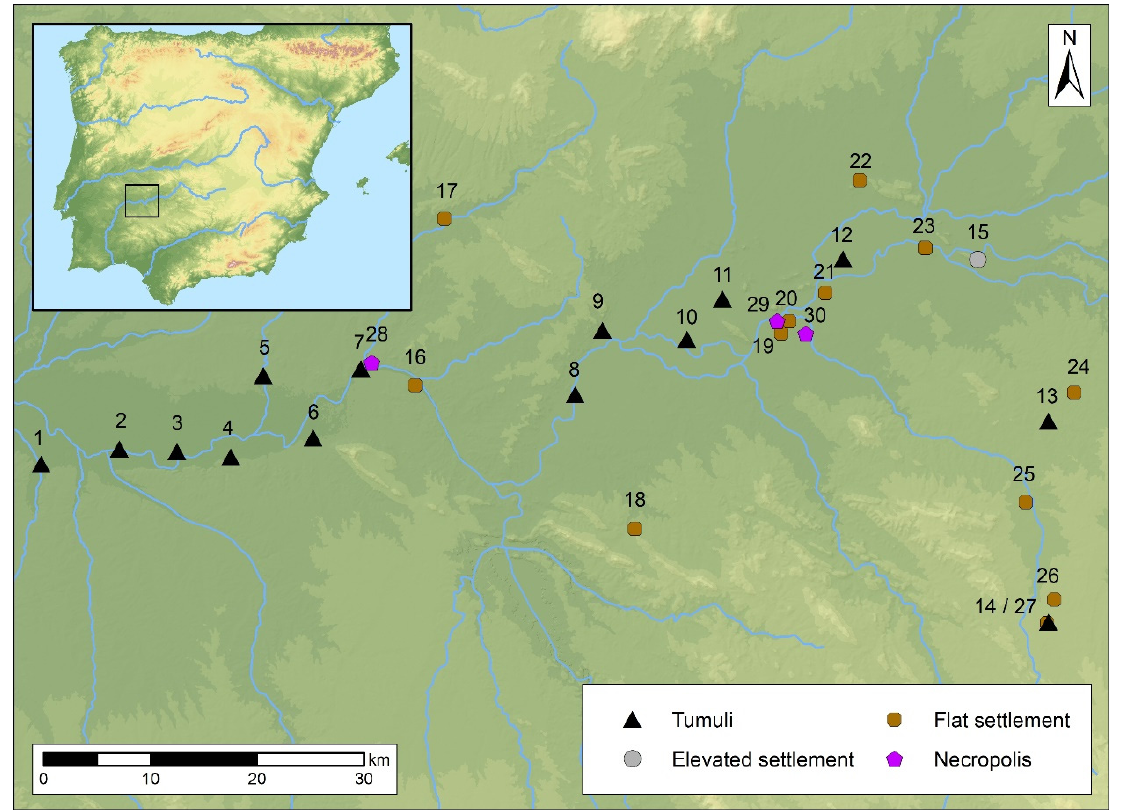
Figure 1. Map showing settlements in the middle Guadiana basin during the first Iron Age. 1. Huerta de Don Mateo; 2. Casas del Cerro de la Barca; 3. Cañada la Virgen; 4. Miraflores; 5. Lácara; 6. Turuñuelo de Mérida; 7. El Tiriñuelo; 8. Turuñuelo (Villagonzalo); 9. Las Madalenas; 10. Casas del Turuñuelo: 11. Las Lomas; 12. La Aliseda; 13. La Mata; 14. Cancho Roano; 15. El Tamborrio; 16. Escuela de Hostelería (Mérida); 17. El Chaparral; 18. El Palomar; 19. La Marquesa; 20. Medellín; 21. La Veguilla; 22. Cerro Manzanillo; 23. Cerro de la Barca—Torruco; 24. Media Legua; 25. La Carbonera; 26. La Mata de Cancho Roano; 27. Las Reyertas; 28. Necropolis of Aljucén; 29. Necropolis of El Pozo; 30. Necropolis of Valdelagrulla.